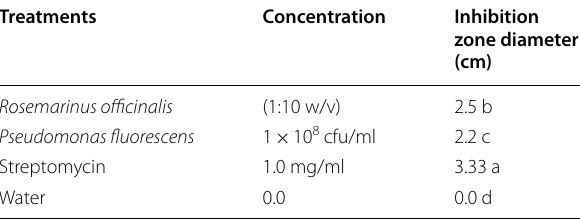
Values in the column followed by different letters indicate significant differences among treatments according to a least significant differences test ( P